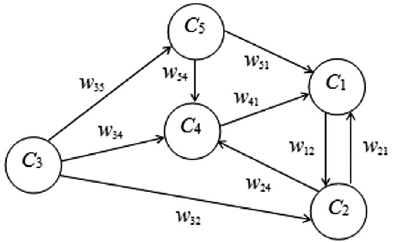
Figure 2. Typical structure of an